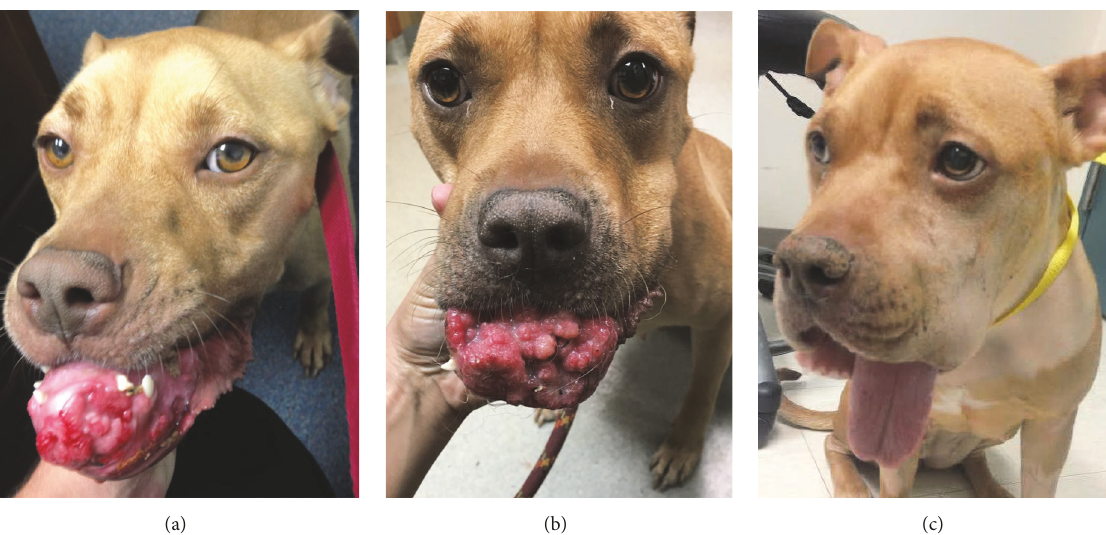
Figure 1: (a) A dog with an inoperable oral SCC and a metastatic lymph node before the study (lymph node staged via FNA and cytology, node not visible in image (a). (b) 3 weeks after the second HylaPlat injection. (c) After 4 HylaPlat injections, lymph node became cancer free and tumor downstaged to resectable and removed (lymph node staged via FNA and cytology, node not visible in image